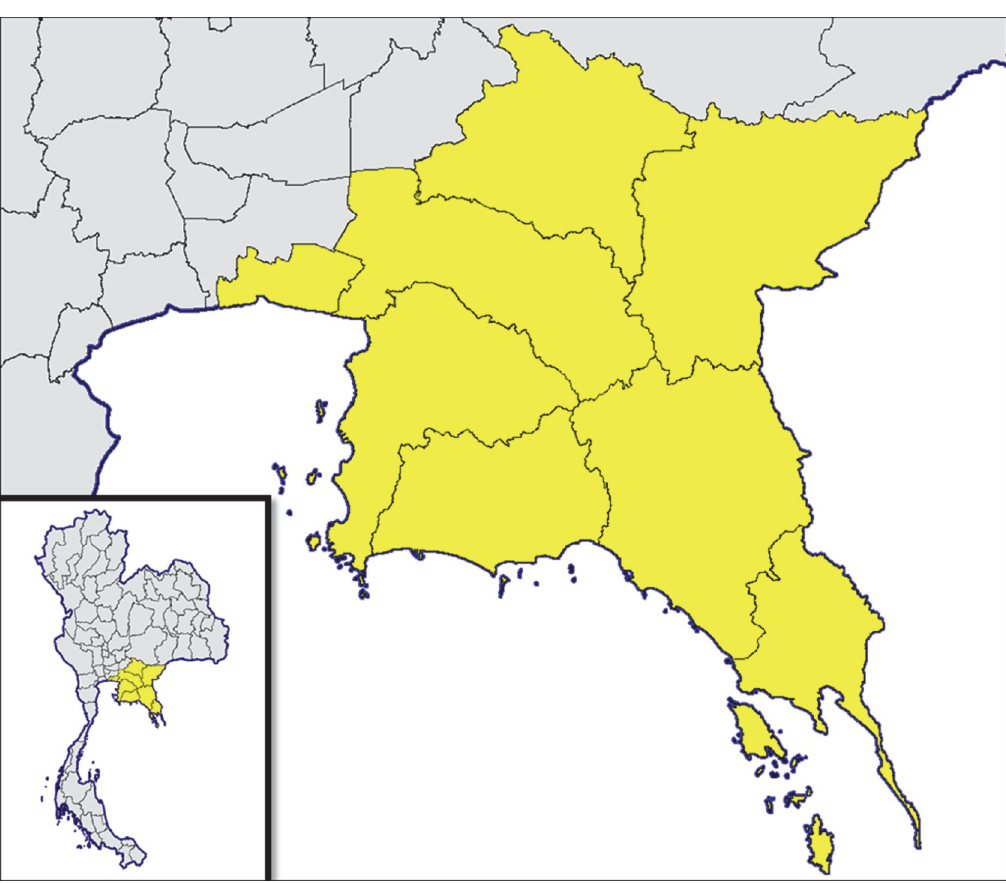
Fig 1. Map displaying the location of the eight provinces in Thailand evaluated for frequency and cause of suspected rabies exposures,